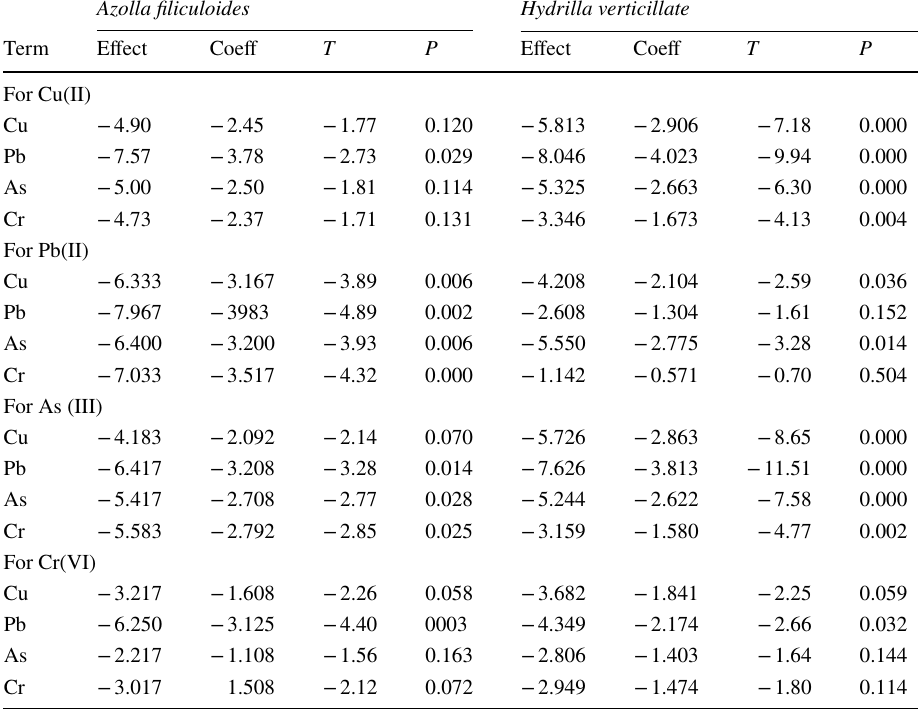
Table 3 Significance of different heavy metals on each other’s metal removal in the study in terms of Student’s